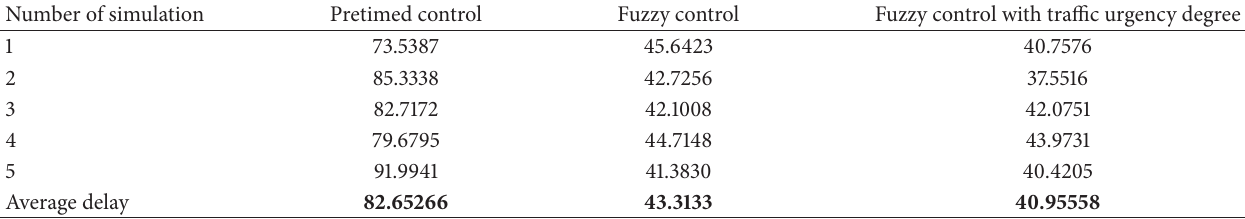
Table 3: Average vehicle delays of low traffic flow.